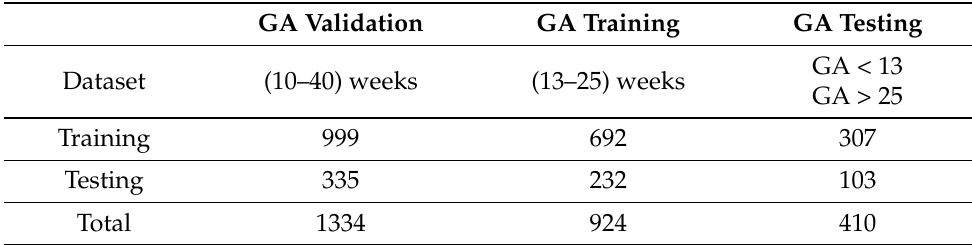
Table 4. Fetal gestational age